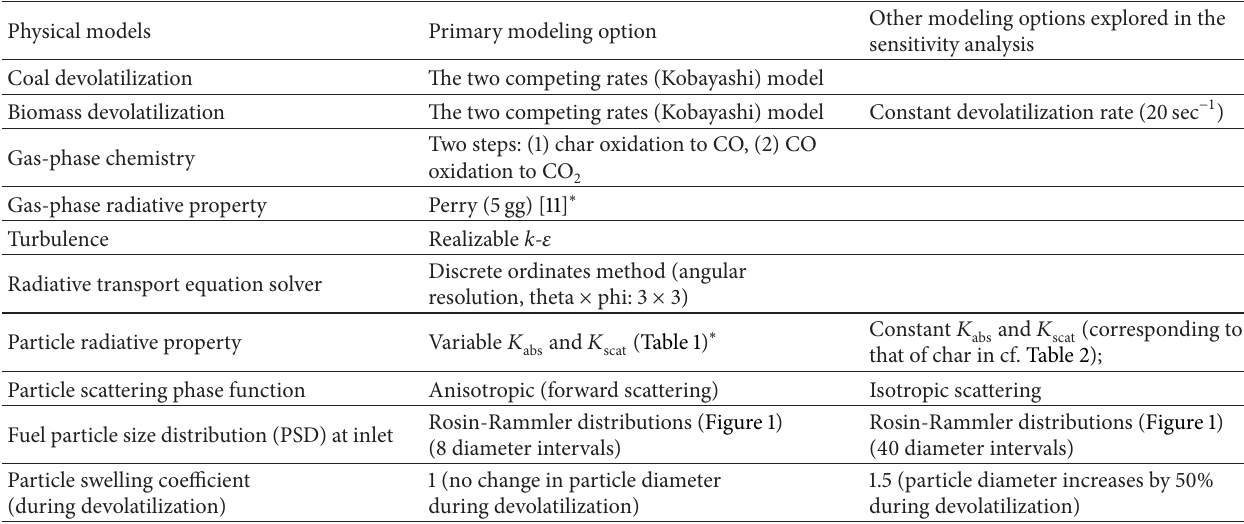
Table 2: Summary of physical models employed in the CFD simulations.